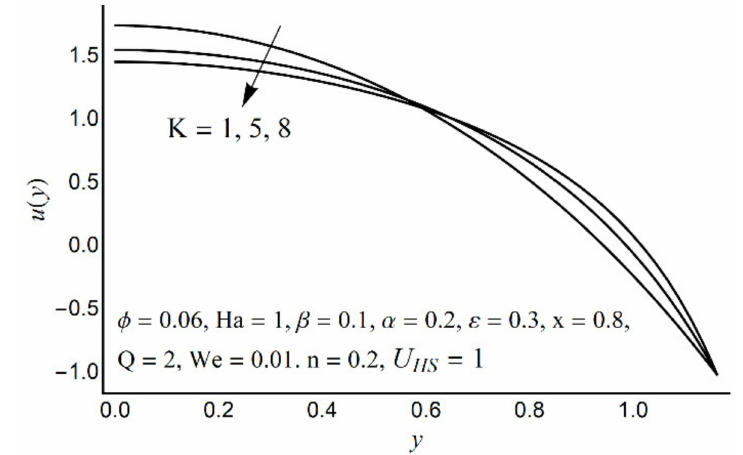
Figure 4. Axial velocity u ( y ) for various K.